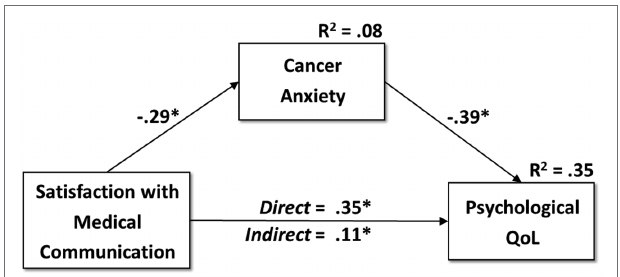
FIGURE 1 | The mediation model in the sample of patients who underwent Prophylactic Bilateral Salpingo-Oophorectomy (PBSO; N = 59). * p ≤